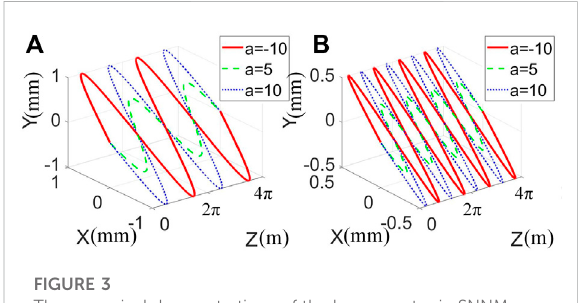
FIGURE 3 The numerical demonstrations of the beam center in SNNM with different shifting parameters. (A) β = 1, (B) β = 0.5.